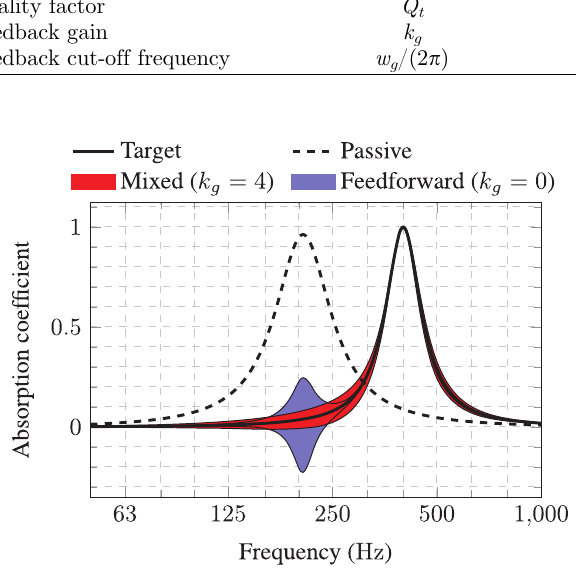
Figure 5. First and third quartiles of the achieved absorption for the two-degree-of-freedom absorber with 10 5 random relative errors of 5% standard deviation on the fi ve estimated parameters.